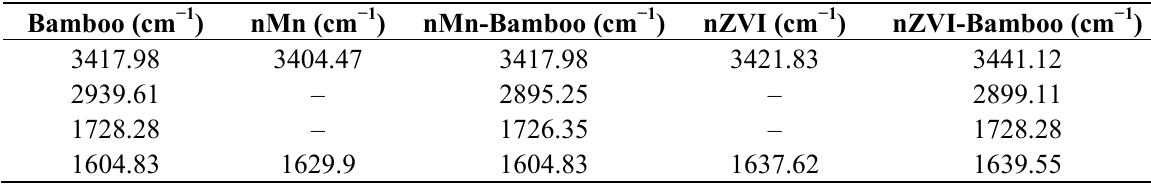
Table 1. Diagnostic bands of bamboo, nMn, nMn-bamboo, nZVI, and nZVI-bamboo composite. Bamboo (cm − 1 )